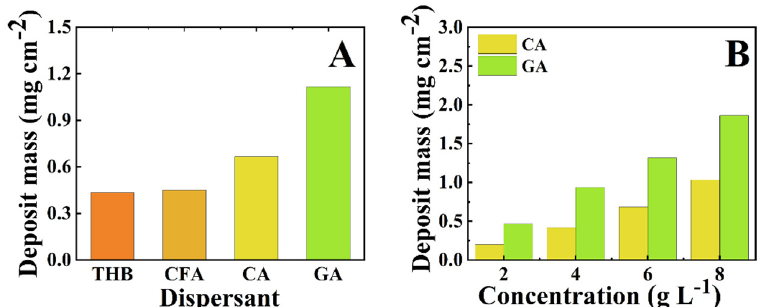
Figure 3. ( A ) Deposit mass achieved for different dispersants using 5 g L − 1 PVDF suspensions con- taining 1 g L − 1 dispersants, ( B ) deposit mass versus PVDF concentration in suspensions, containing 1 g L − 1 dispersants for deposition time of 5 min and deposition voltage of 100 V.